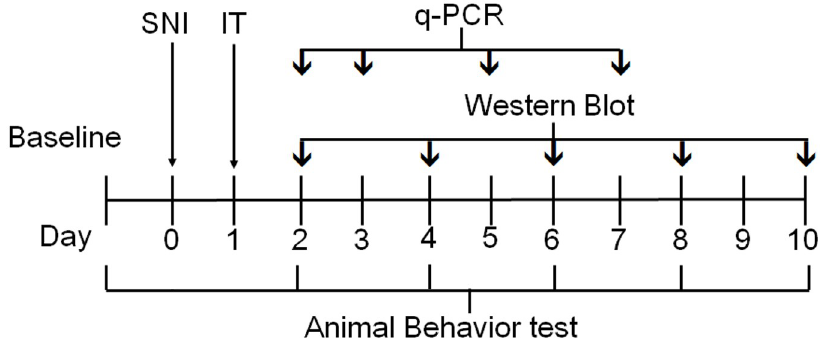
Fig 1. Experiment timeline. Timeline of the experimental protocols, outlining the periods of animal behavior testing, spared nerve injury (SNI) surgery, real-time quantitative polymerase chain reaction (RT-qPCR), and western blot. IT,